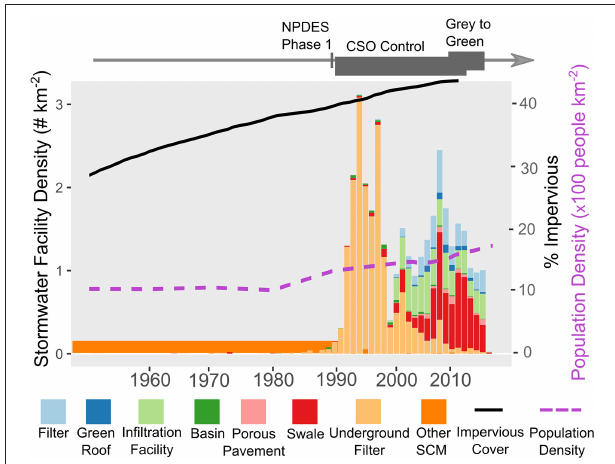
FIGURE 7 | A timeseries of SCM construction in Portland, represented as the number of facilities built during a given year, normalized by the current area of the city. The arrow at the top denotes important events influencing stormwater management, the black line graph represents impervious surface change in Portland over several decades, and the dotted purple line graph indicates change in population density. This SCM timeseries is missing facilities which did not have known construction years, so is more representative of relative changes over time. Vegetated ditches are almost completely missing from the SCM database, but a bar has been added (under the type “Other”) to indicate that the majority were likely constructed prior to